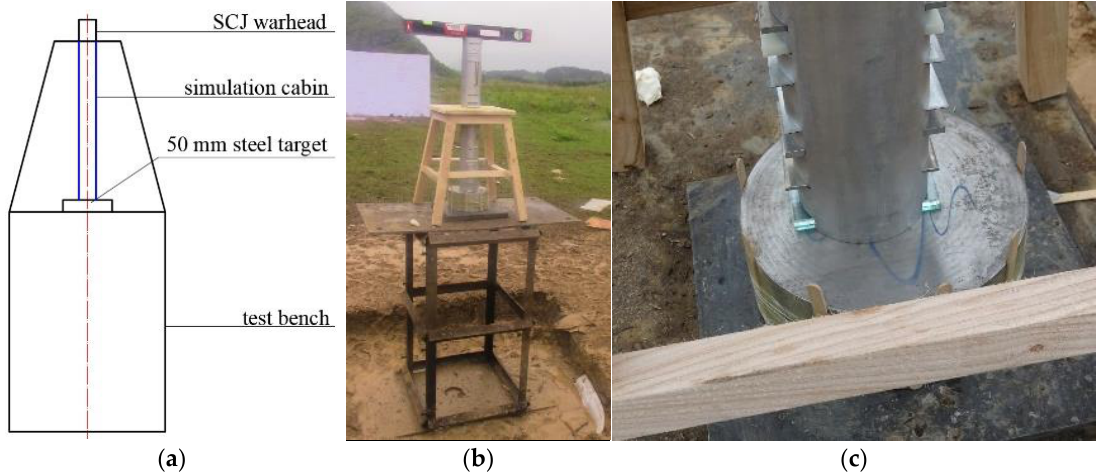
Figure 12. Penetration experiment setup with simulation cabin: ( a ) the experimental principle diagram, ( b ) the experimental setup, and ( c ) physical drawing of simulation cabin placed on 50 mm thick Q235 steel target.